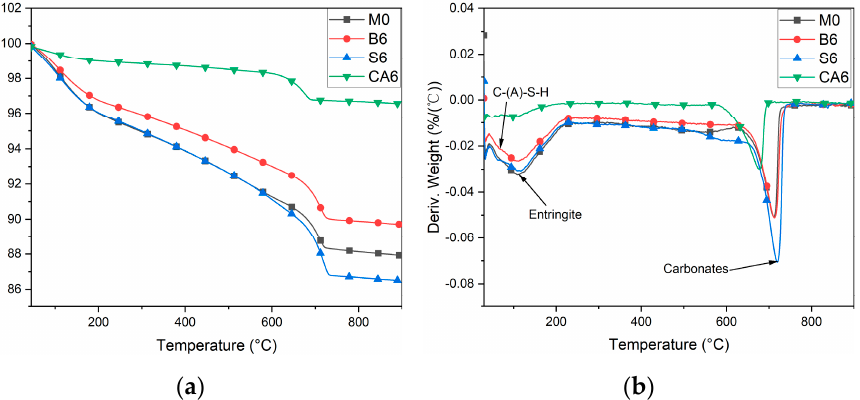
Figure 13. Thermal analysis of M0, B6, S6, and CA6. ( a ) Temperature-Weight Curves; ( b ) Temperature- Deriv Weight